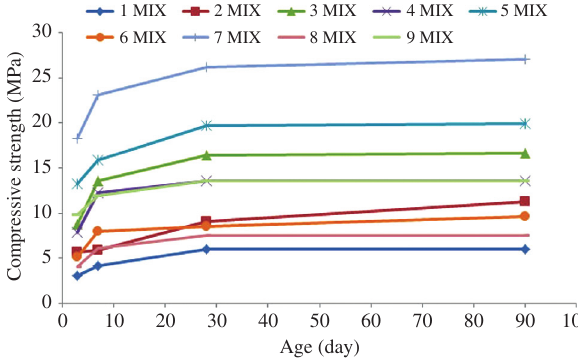
O on 28-day compressive strength for Figure 10 The effect of Na 2 samples cured at 45 ° C and constant w/b.